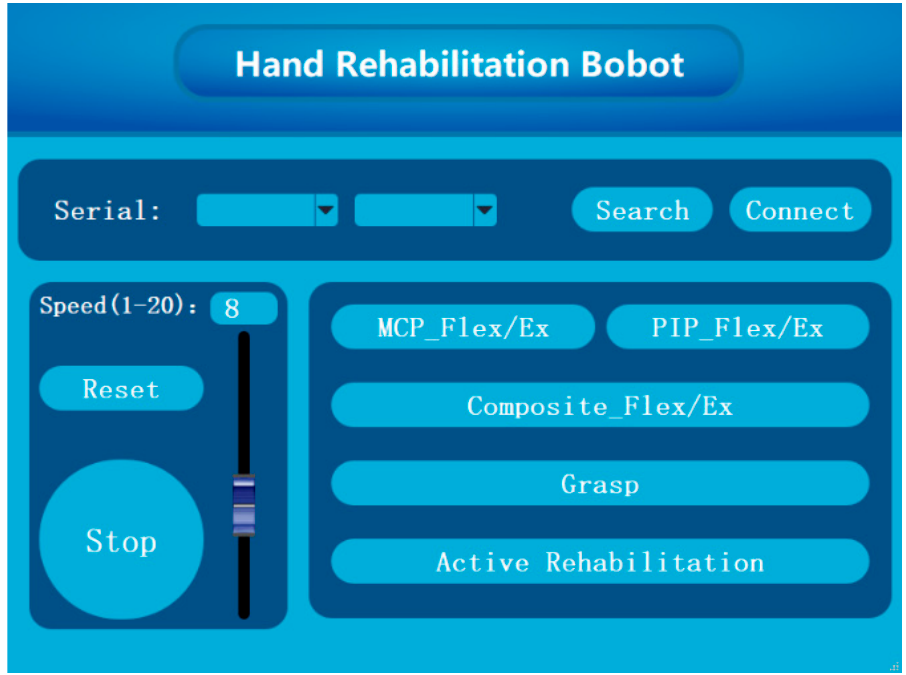
Figure 10. The graphical user interface designed by Qt.